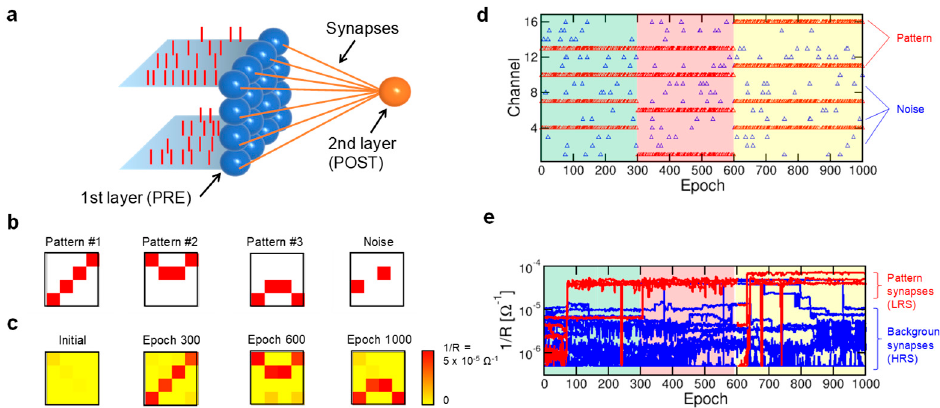
Figure 16. ( a ) Schematic sketch of a single-layer perceptron network where a 4 x 4 input layer is fully connected to a single POST. ( b ) Sequence of three visual patterns (Pattern #1, Pattern #2, and Pattern #3) submitted to the neural network during training process and an example of a random noise image, which is alternatively applied to patterns according to a stochastic approach. ( c ) Conductance / weight color plots measured at epochs 0, 300, 600, and 1000 evidencing the ability of the synaptic weights to adapt to submitted patterns thanks to selective potentiation of pattern synapses and noise-induced depression of background synapses. ( d ) Raster plot of PRE spikes applied to pattern and background input channels during the learning experiment. ( e ) Time evolution of the measured synaptic conductance during three phases of the unsupervised learning experiment showing convergence of pattern / background synapses to LRS / HRS. Reprinted from [152].